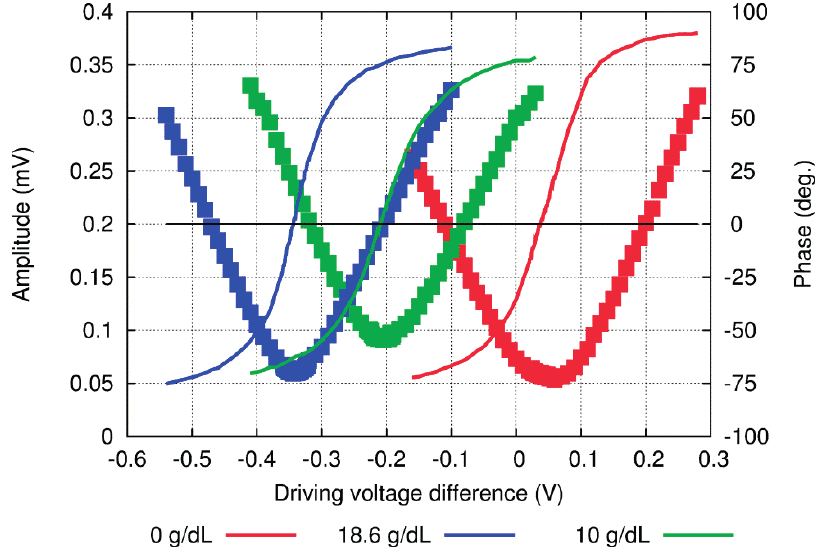
Figure 2. Amplitude (dots) and phase (lines) raw experimental results when the DV was scanned around the 0-phase value at several concentrations of aqueous solution of